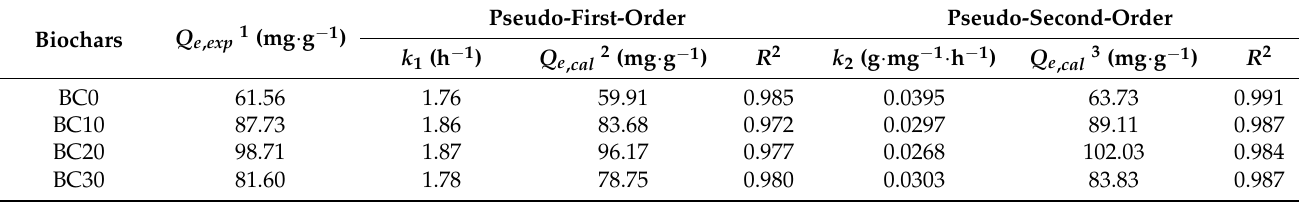
Table 4. Fitting parameters of the pseudo-first-order and pseudo-second-order kinetics models by biochars.